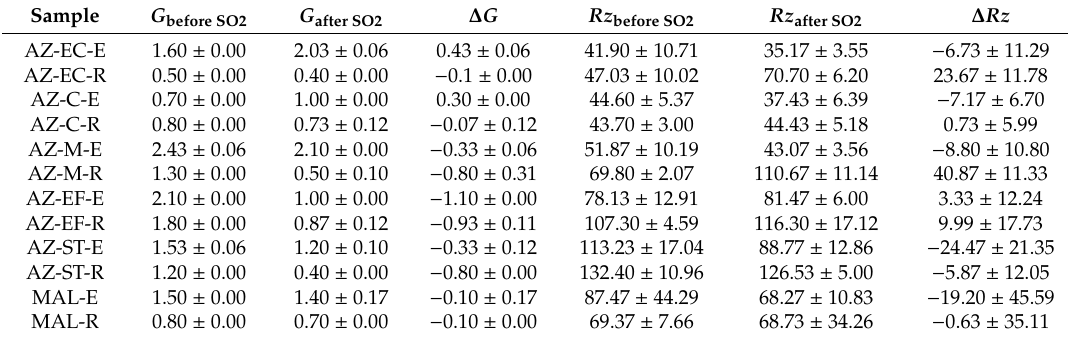
Table3. Glossvalues( G ),glossvariations( ∆ G ),averagemaximumprofileheight( Rz ), andcorresponding variation ( ∆ Rz ) between fresh (before SO 2 ) and SO 2 aged (after SO 2 ) paint mock-ups. Standard deviations are also